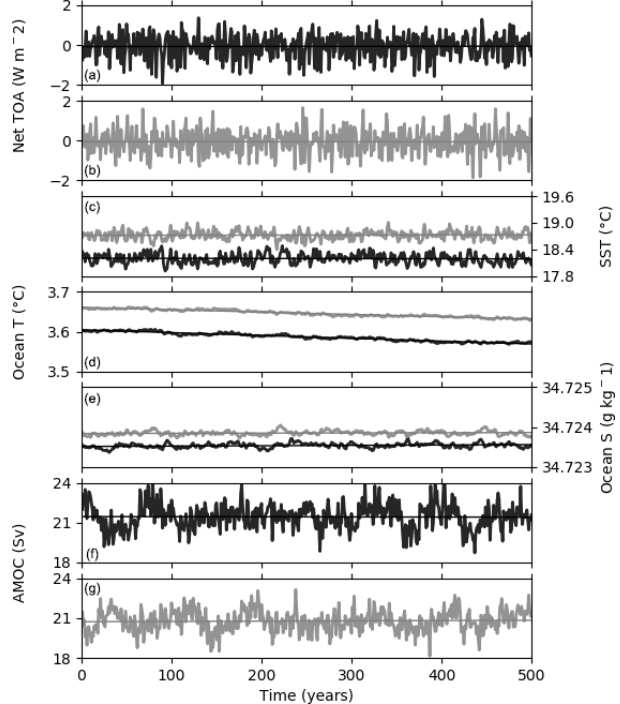
Figure 2. Pre-industrial control experiment characteristics for NorESM2-LM (black lines) and NorESM2-MM (grey lines). Time evolution of globally averaged top-of-the-atmosphere (TOA) net radiative balance (first and second panel from top), sea-surface temperature (SST) (third panel), ocean temperature (fourth panel), ocean salinity (fifth panel), and AMOC at 26.5 ◦ N (bottom two pan- els) for model years